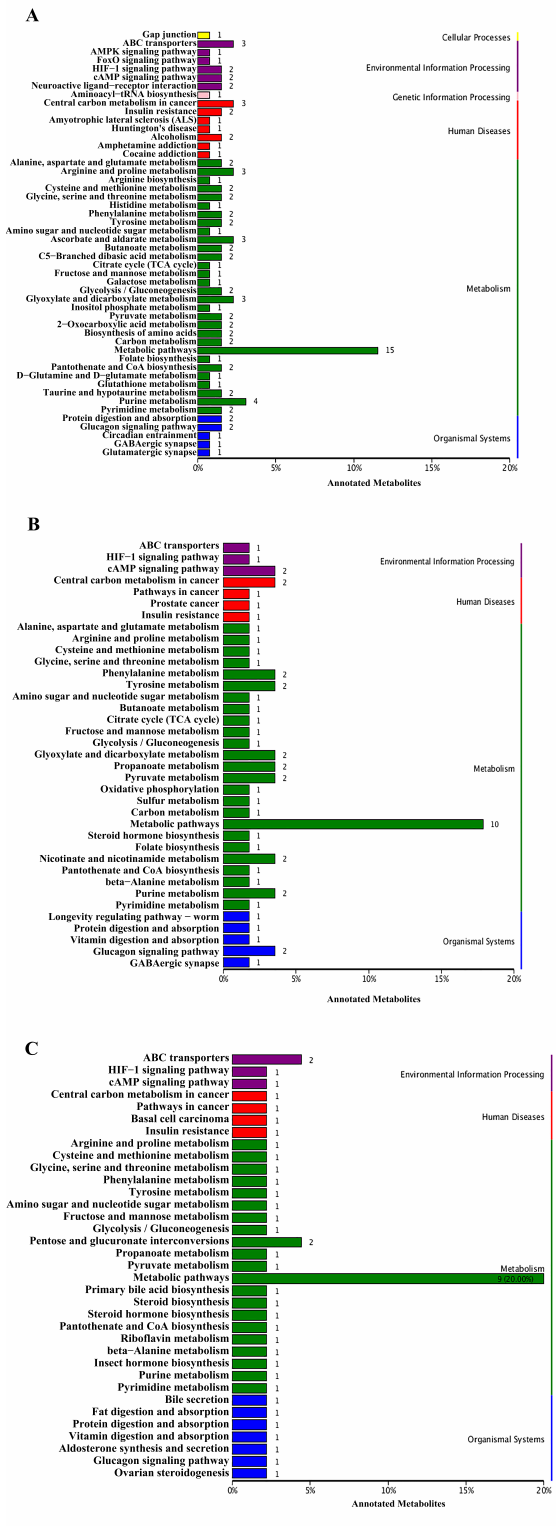
Figure 4. KEGG enrichment of different metabolites between control and dead group ( A ), control and moribund group ( B ), and control and survived group ( C ) in Macrobrachium nipponense